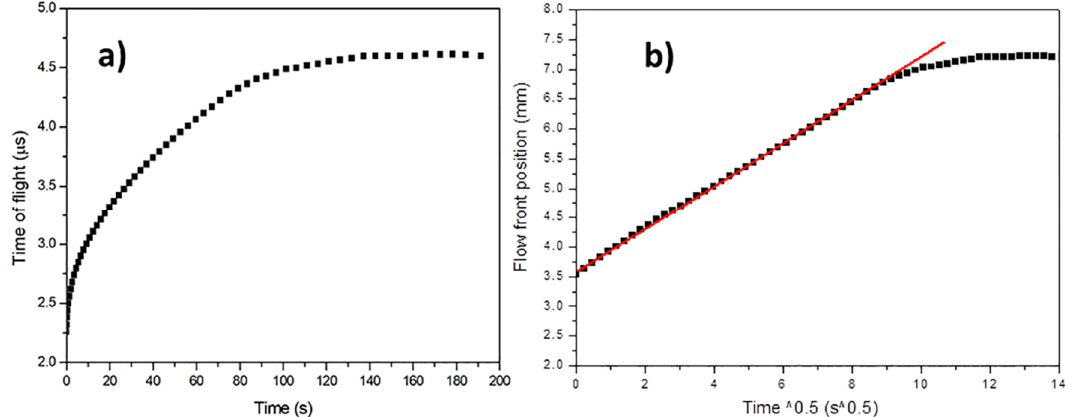
Figure 6. Preform C at fiber volume fraction of 0.628: ( a ) measured ultrasonic time of flight during the infusion; ( b ) calculated flow front position from ultrasonic data.